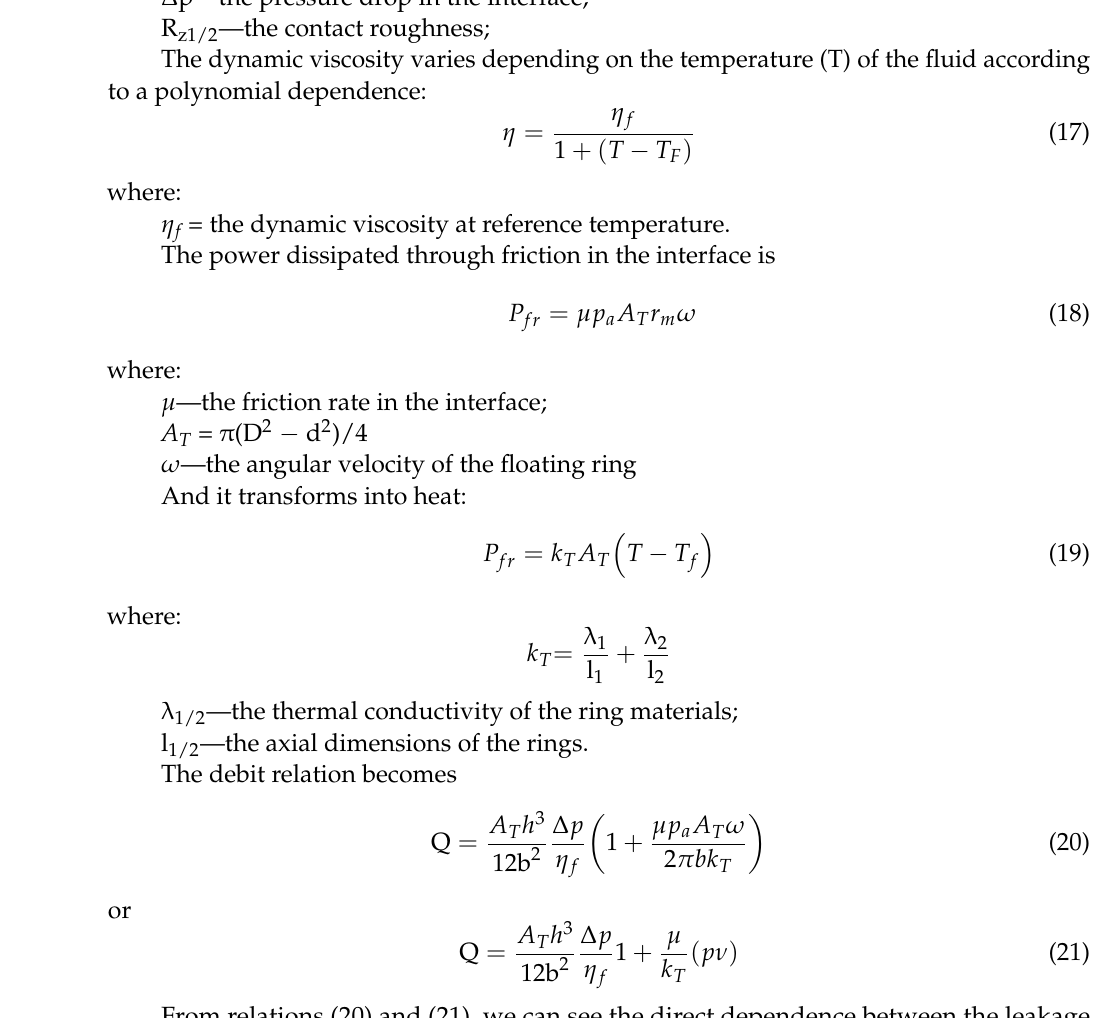
Figure 16. Variation of the leakage loss flow at a frontal seal EF19 × 45.4 × 13.3 depending on the angular speed and for different material couplings of the primary seal. The results of the analysis highlight the fact that the flow rate of leaks varies linearly with increasing the angular speed of the pressure ring and is independent of the materials used in the primary seal. The values of leakage losses due to the leakiness of the MFS analyzed are far below the values allowed by Richtlinie VDI 2440, namely 1 cm 3 /h (12 g/h) [37]. 6. Discussion From a thermal point of view, the physical-mechanical and thermal properties of the working fluid and the materials of the primary seal of the MFS have a major influence on the operating behavior of the MFS. Thus, the materials of the primary seal must have a low coefficient of friction, to allow a quick evacuation of the heat produced, to have a low coefficient of expansion and not to damage each other. From the FEM analysis, the results are as follows:  The maximum temperature is reached in the forecast area of the interface of the pri- mary seal;